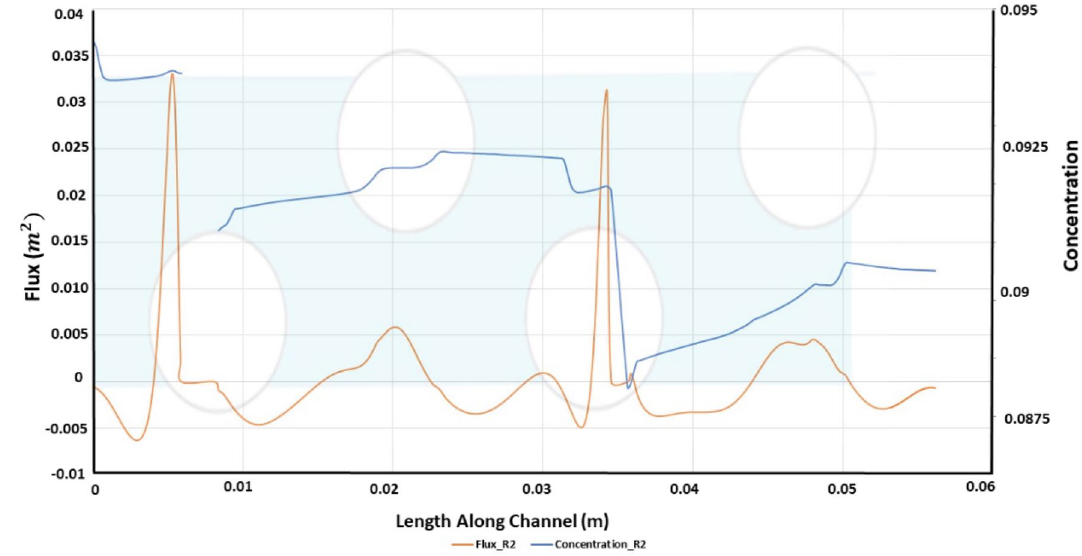
Figure 12. Length along channel vs flux and concentration for